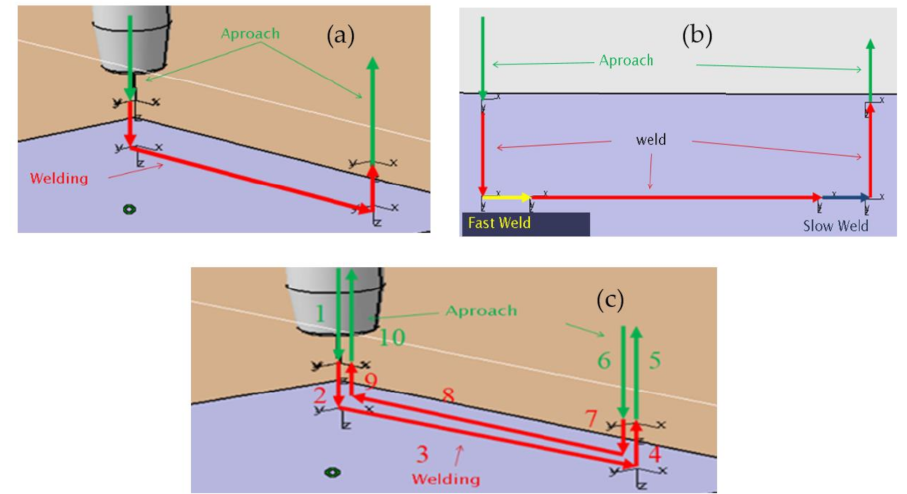
Figure 3. Programming path strategies in Delmia ® : ( a ) go, ( b ) go with modified enter and exit conditions, ( c ) back (1-2-3-4-5) and forth (6,7,8, 9, 10) path